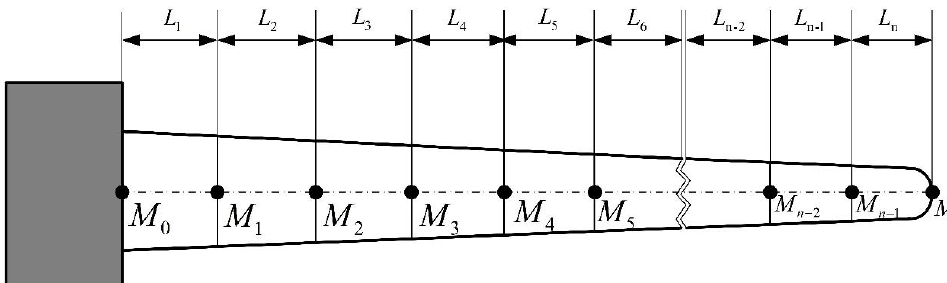
Figure 26. Blade segmentation model [49].